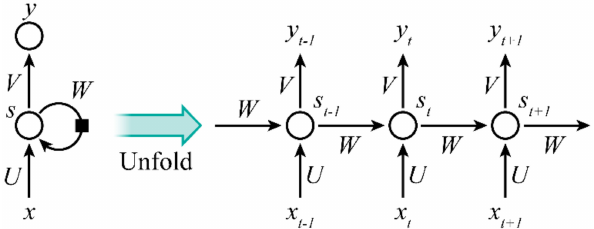
Figure 1. Standard RNN model (Source: [4]).